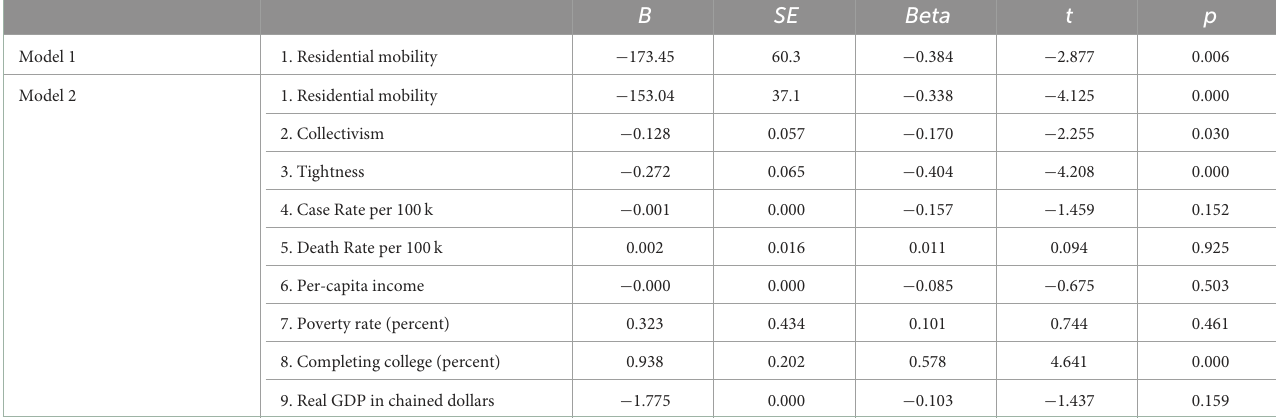
TABLE 2 Predictors of total population fully vaccinated for COVID-19 across U.S.